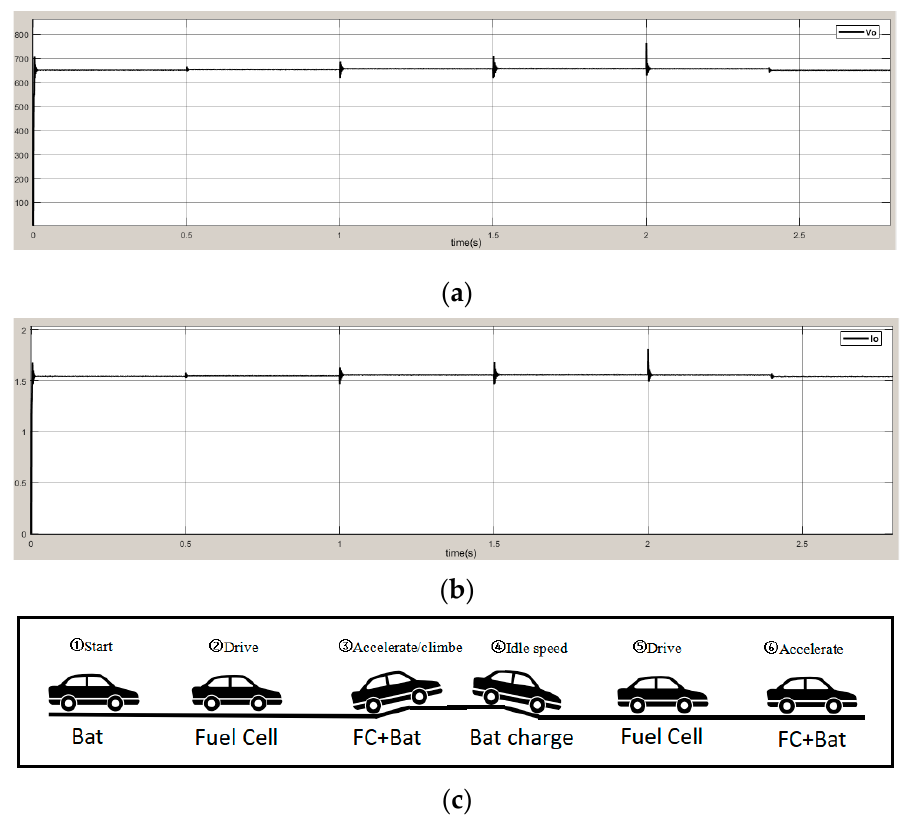
Figure 13. The output during state switching and its sequence: ( a ) voltage waveform of operating state switching; ( b ) current waveform of operating state switching; ( c ) switching sequence of operating states.